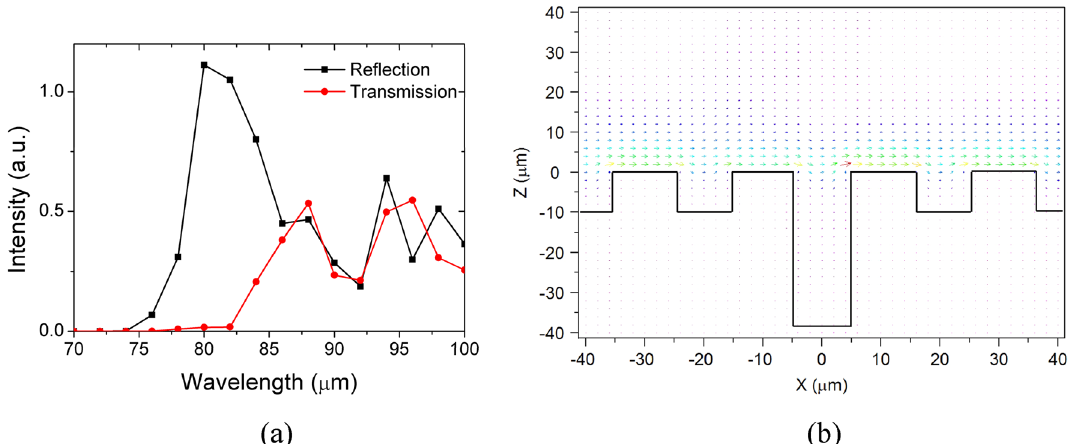
Figure 7. The reflection (square dotted black line) and transmission spectrum (circle dotted red line) of the single obstructed groove (Δ n = 0, Δ d = 36 μm) at around 3.75 THz (corresponding to wavelength of 80 μm) ( a ), The Poynting vector distribution of the metasurface at wavelength of 84 μm ( b